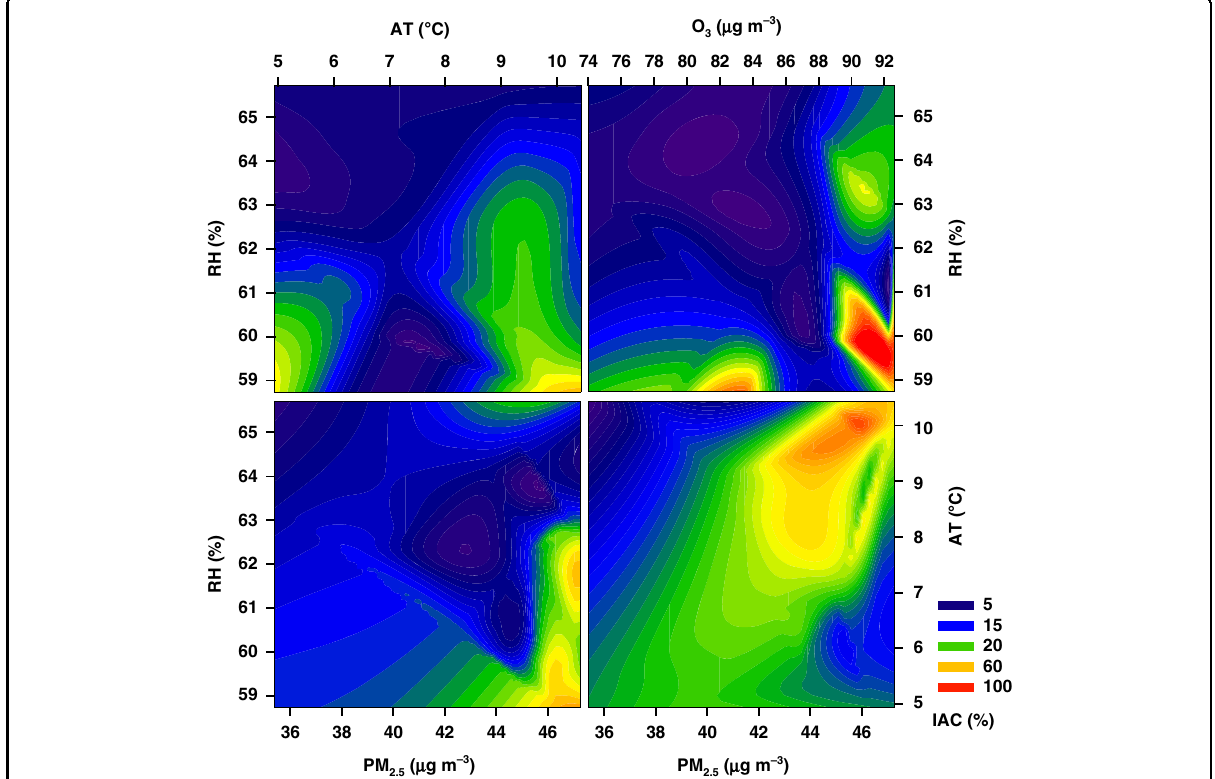
Fig. 4 The joint relationships between IAC and multiple environmental factors (e.g., PM 2.5 , O 3 , Air temperature, and Relative humidity) in Northeast China. IAC incidence of allergic conjunctivitis, AT Air temperature, RH Relative